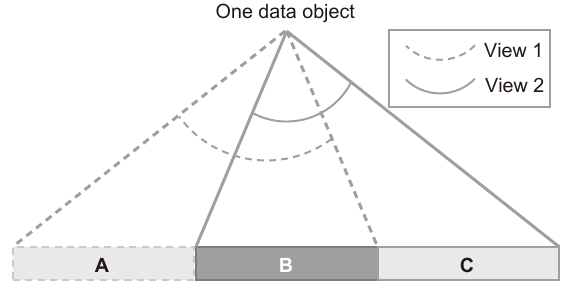
Fig. 1 Illustration of complementary and consensus principles [16]